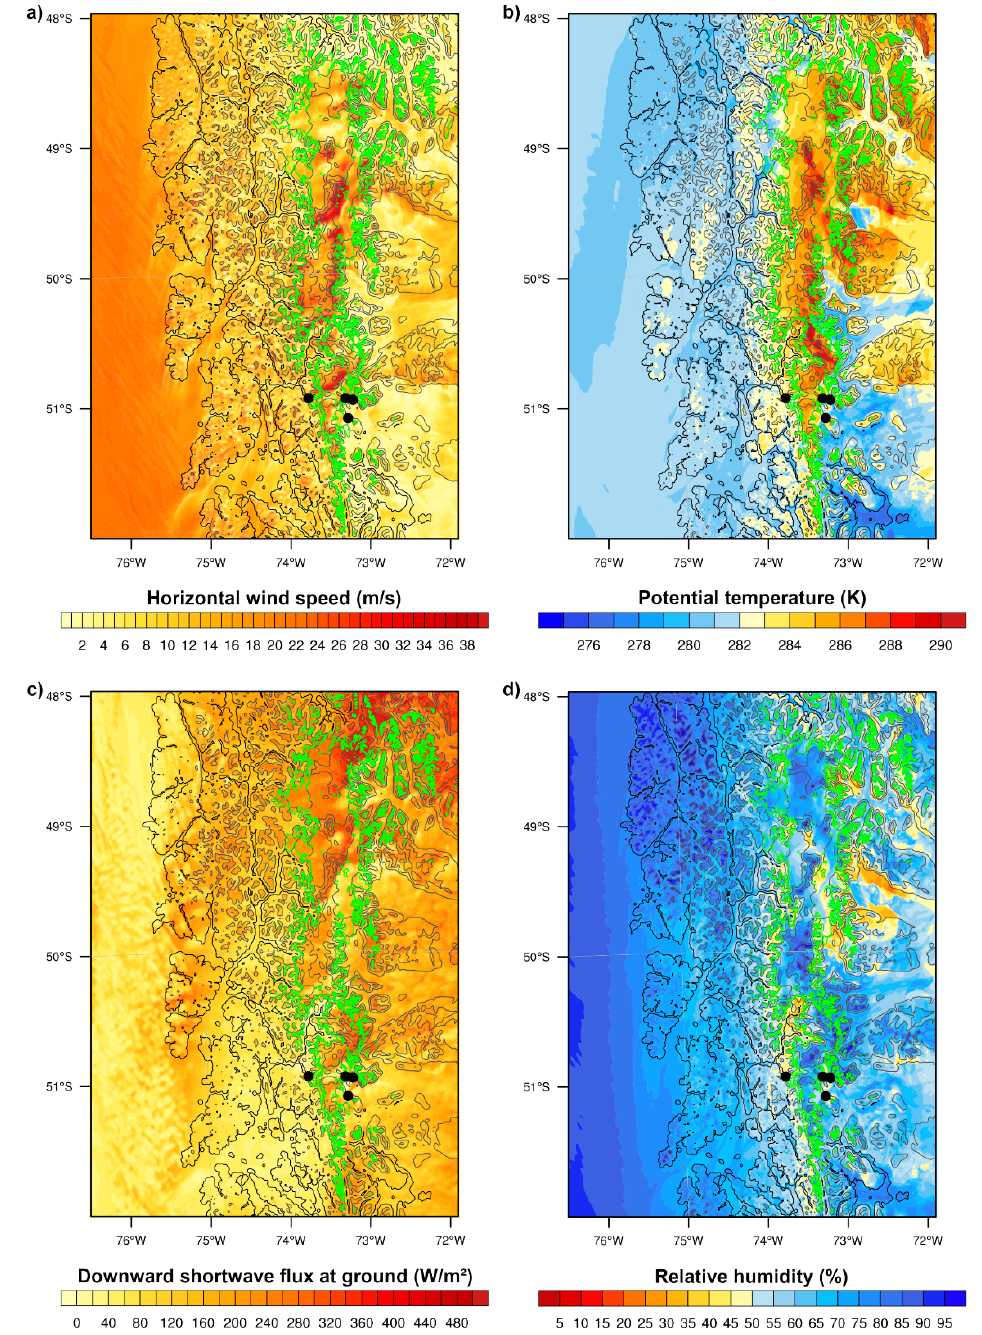
Figure 9. Surface conditions of ( a ) the horizontal wind speed 10 m above ground, ( b ) potential temperature 2 m above ground, ( c ) downward shortwave flux at the ground, and ( d ) relative humidity 2 m above ground for the transition case on 8th August 2018 18:00. Black dots indicate the AWS locations. The green contour outlines the glacierized area. Black/grey contours mark the terrain height in 500 m intervals. Data are derived from WRF.